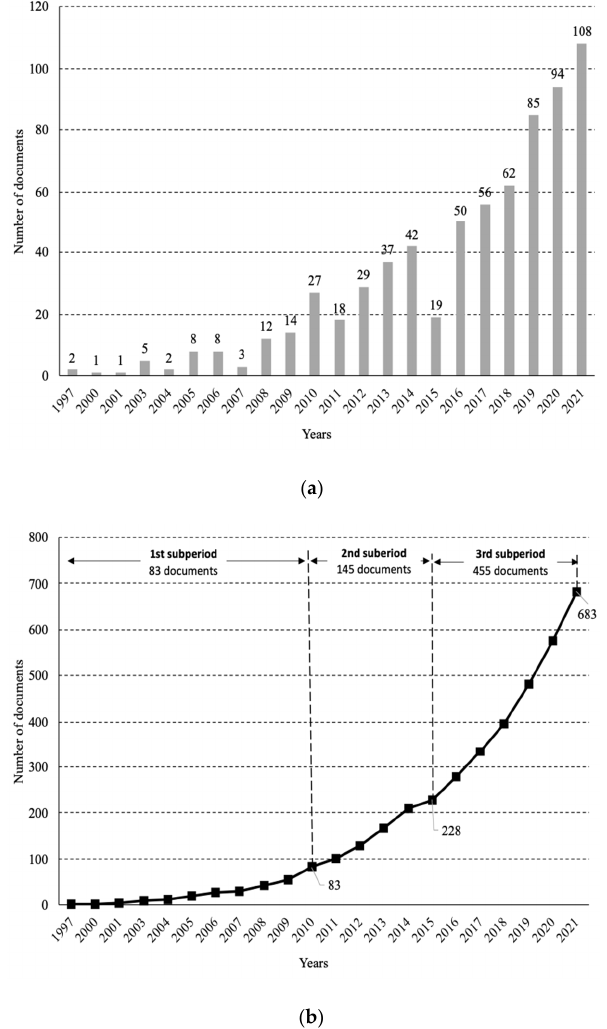
Figure 3. Number of documents published in the time horizon (1997 ‒ 2021) and subperiod: ( a ) document per year and ( b ) accumulated number of documents.